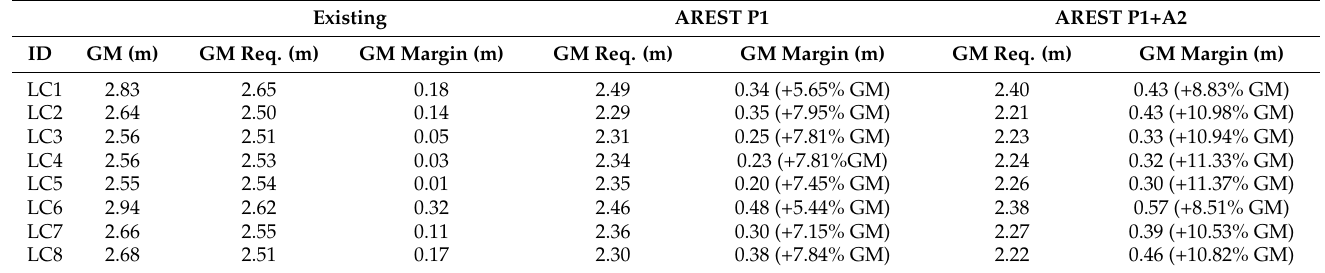
Table 10. Loading conditions and GM margins for cruise ship C1 with AREST